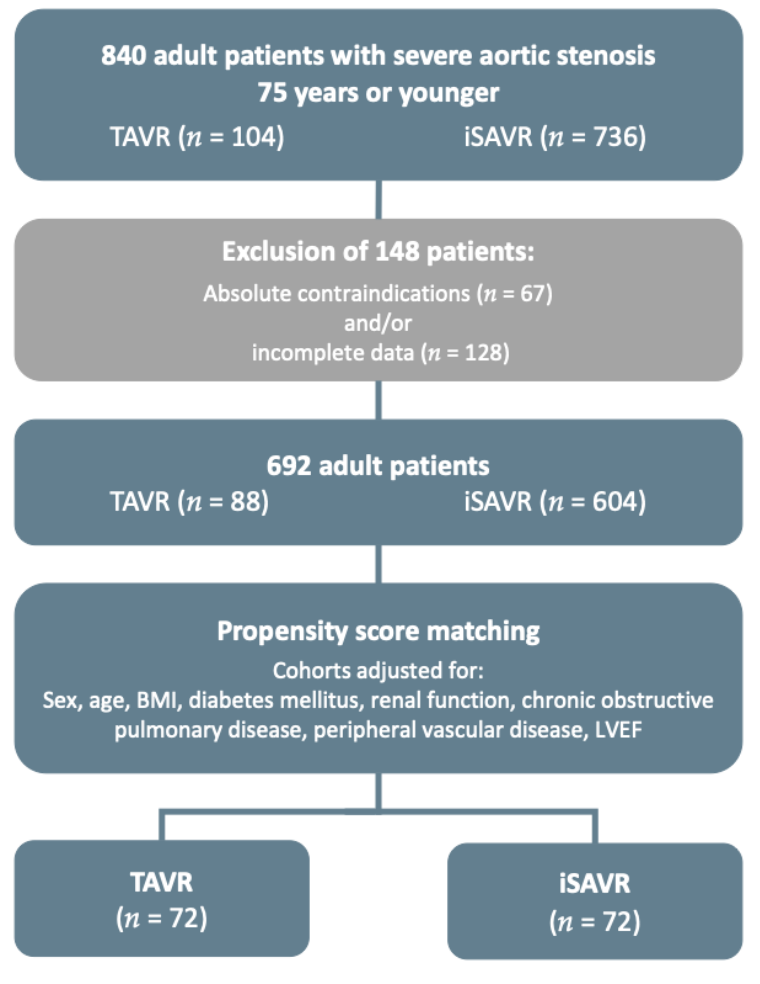
Figure 1. Patient selection and propensity score matching flow-chart (BMI—body mass index, LVEF—left ventricular ejection fraction).